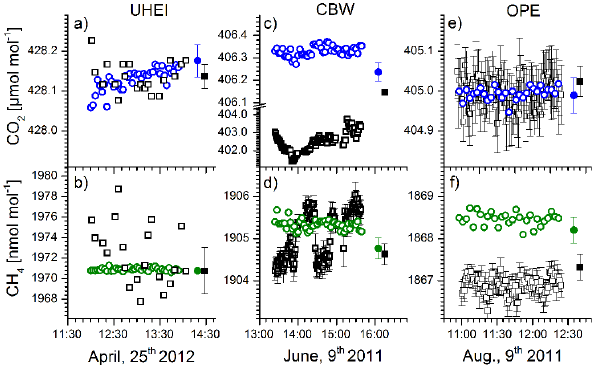
Fig. 2. Sample intake system tests at the three stations: Open symbols represent individual measurements via the entire sample intake system, including intake line, pumps and drying systems. Filled symbols denote averaged measurements of the same cylinder without the intake system. Black symbols represent station instru- ment, coloured symbols measurements with the